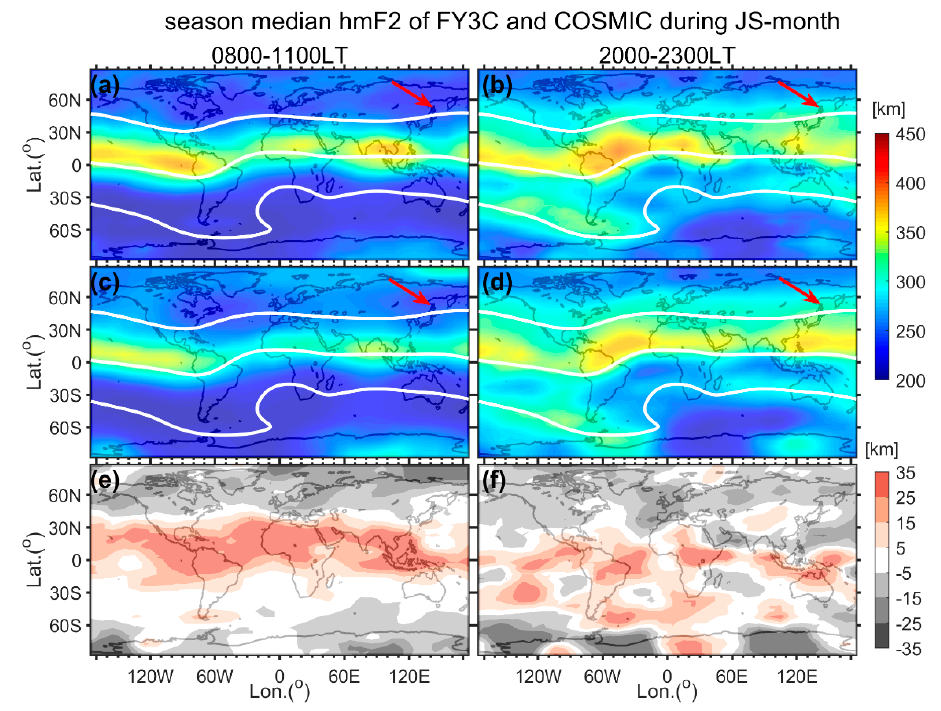
Figure 11. Ionospheric climatological characteristics of season median hmF2 observed by FY3C/GNOS and COSMIC and their differences at 0800–1100LT and 2000–2300LT during JS-month (2016.128–2016.218). The red arrow points to the diurnal variation of hmF2, in which the nighttime hmF2 enhancement, namely, the general WSA can be clearly observed. Refer to Figure 10 for more details.